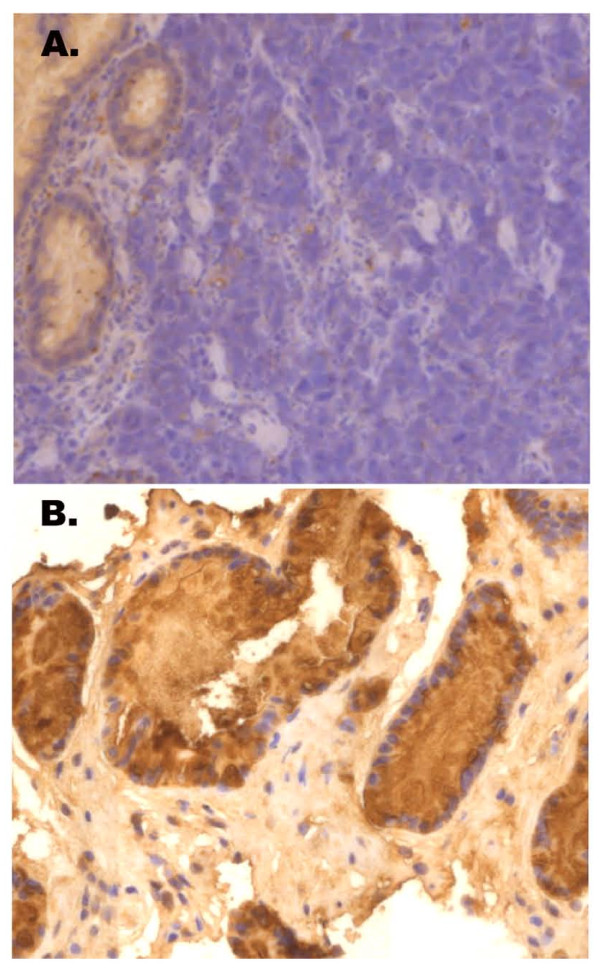
Representative TFF1 immunohistochemical staining results for (A) a gastric adenocarcinoma demonstrating the loss of TFF1 expression, and (B) normal gastric mucosa from a healthy volunteer expressing TFF1 in gastric epithelial cells. (Magnification = 200x)